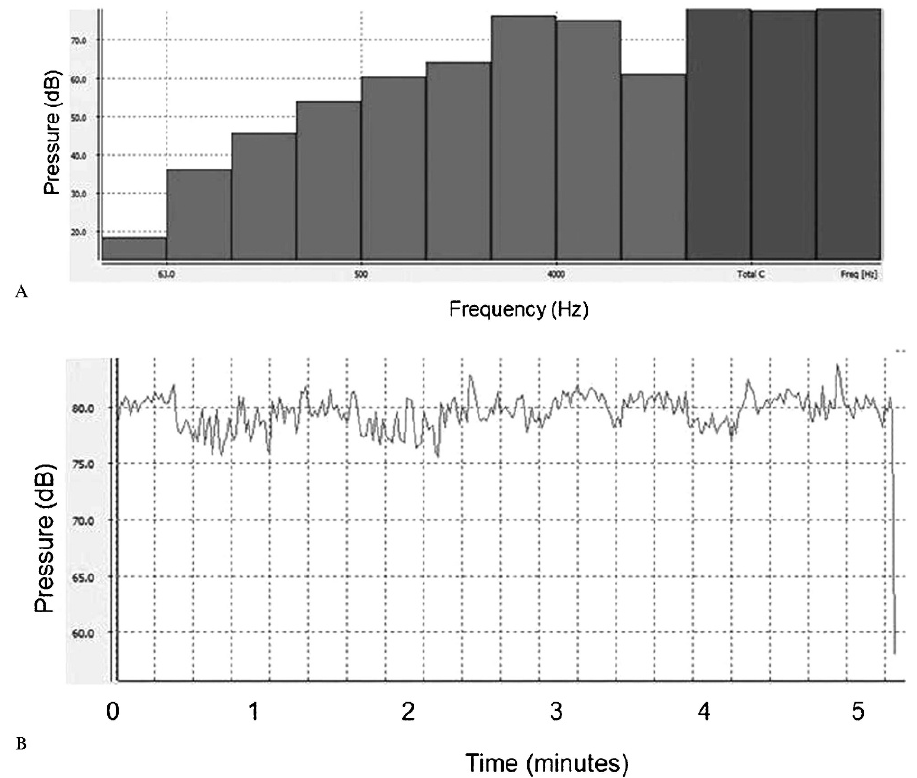
Figure 2 - Equivalent sound level of auditory musical stimulation in the heavy metal